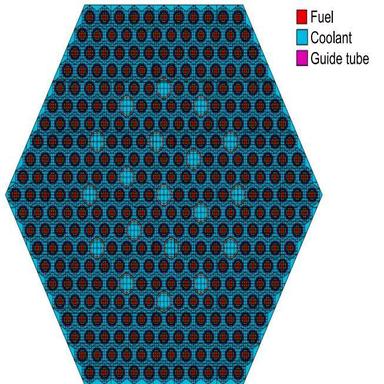
Fuel assembly geometry.